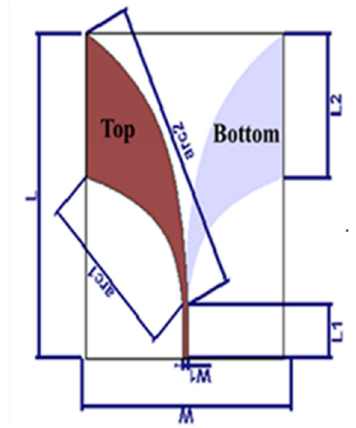
Figure 2. The geometry design of the AVA.